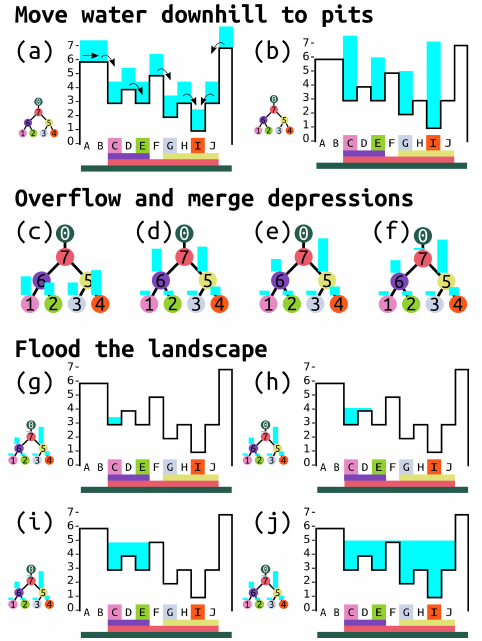
Figure 4. Visual overview of the algorithm. Black outlines repre- sent the elevations of the cells. Blue areas are the heights of water in each cell or depression within the depression hierarchy. Capital letters label cells, and numbers on colored dots label depressions. Colors at the base of each panel match the colored dots and indicate to which depression each cell belongs. The algorithm consists of three major stages (Fig. 5). From its initial distribution (a) , water is moved downhill following flow directions in the steepest downslope direction from each cell, as indicated by the arrows. Water continues to move downslope until it reaches the pit cells ( b , Sect. 3.1). Wa- ter is then moved within the depression hierarchy ( c–f , Sect.